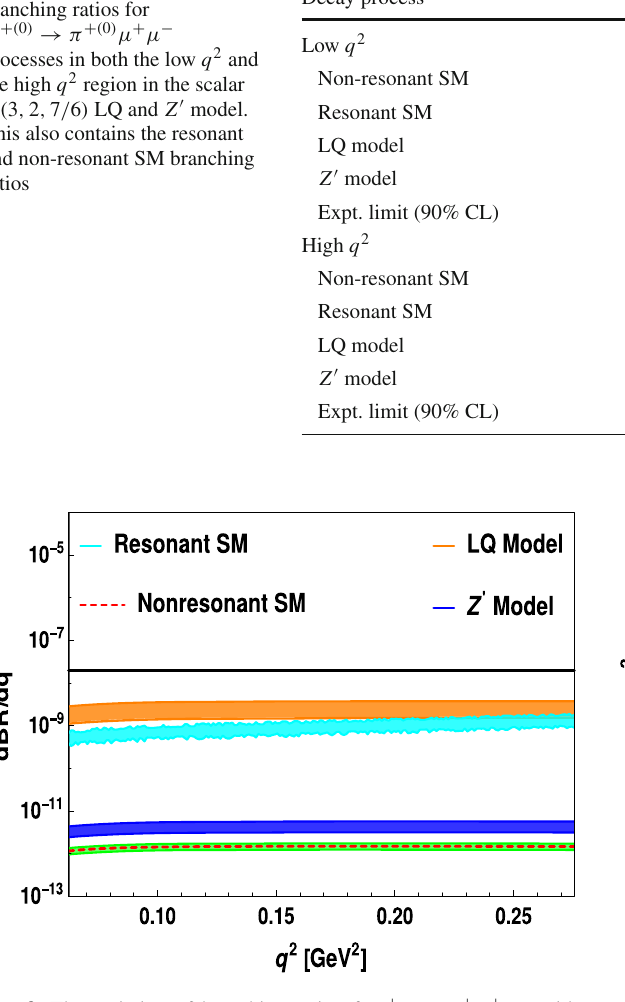
non-resonantSMandthe cyan bandsarefortheresonantSM.The green bands stand for the theoretical uncertainties from the input parameters in the SM. The solid black line denotes the 90% CL experimental upper limit